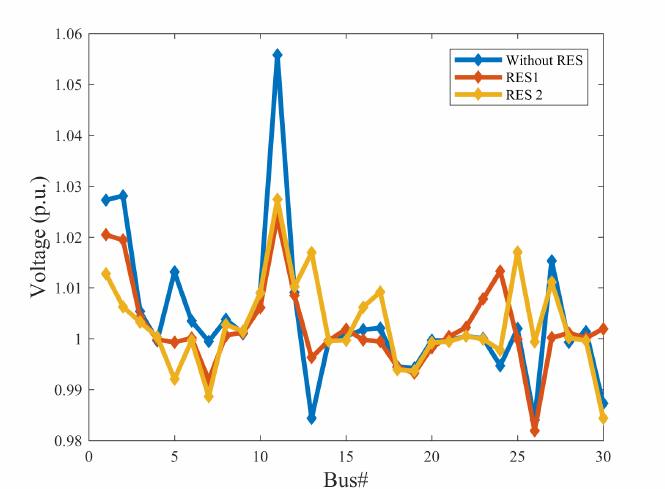
Figure 11. Voltage deviation (p.u.) IEEE 30-bus system, IEEE 30-bus Modified (1) and IEEE 30-bus Modified